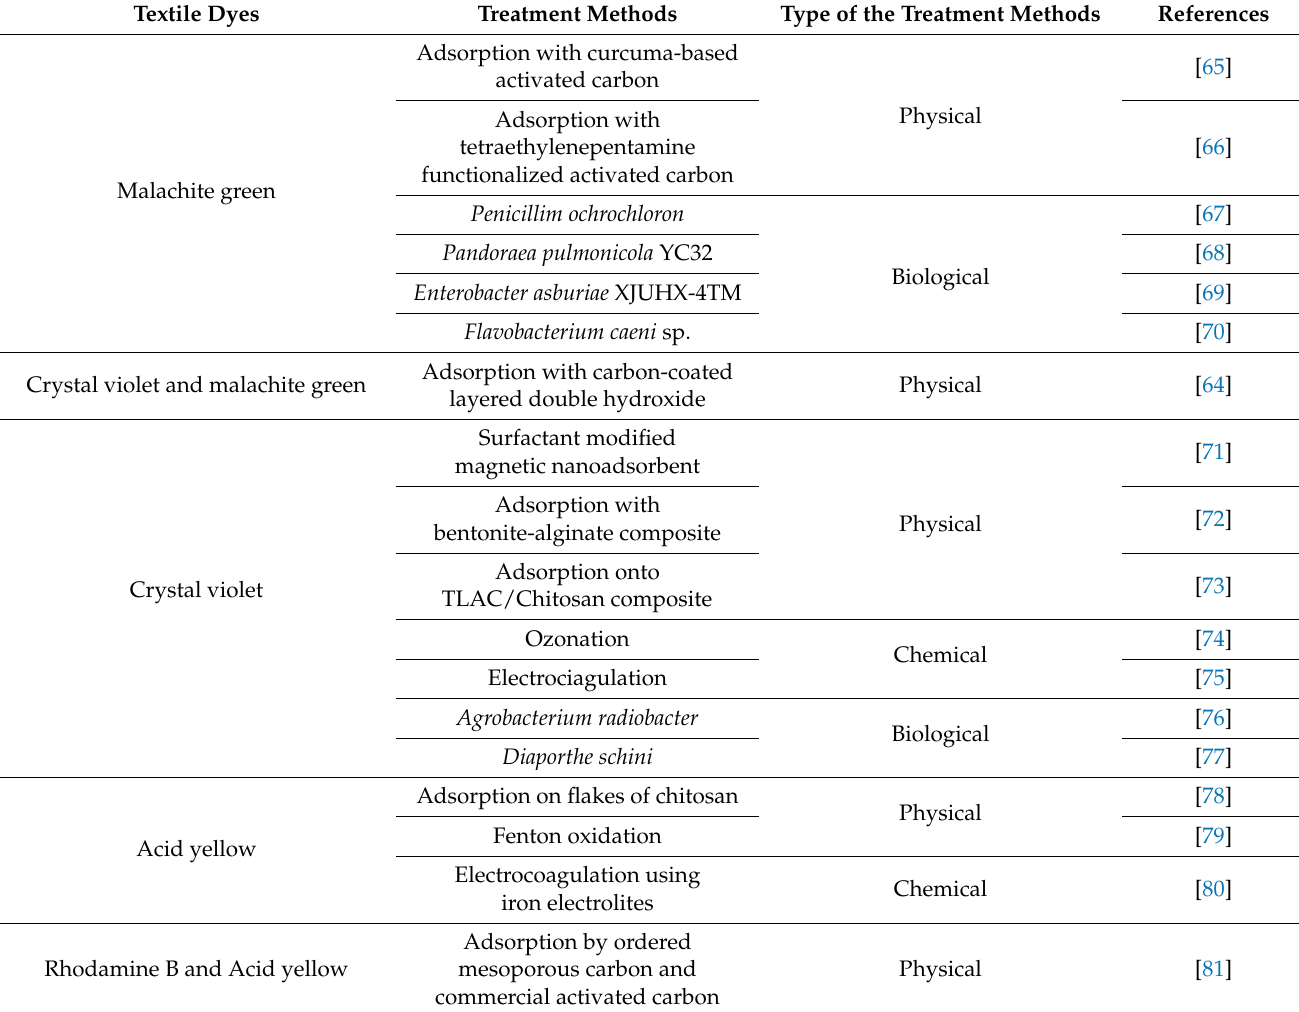
Table 1. Examples of textile dyes and their treatment